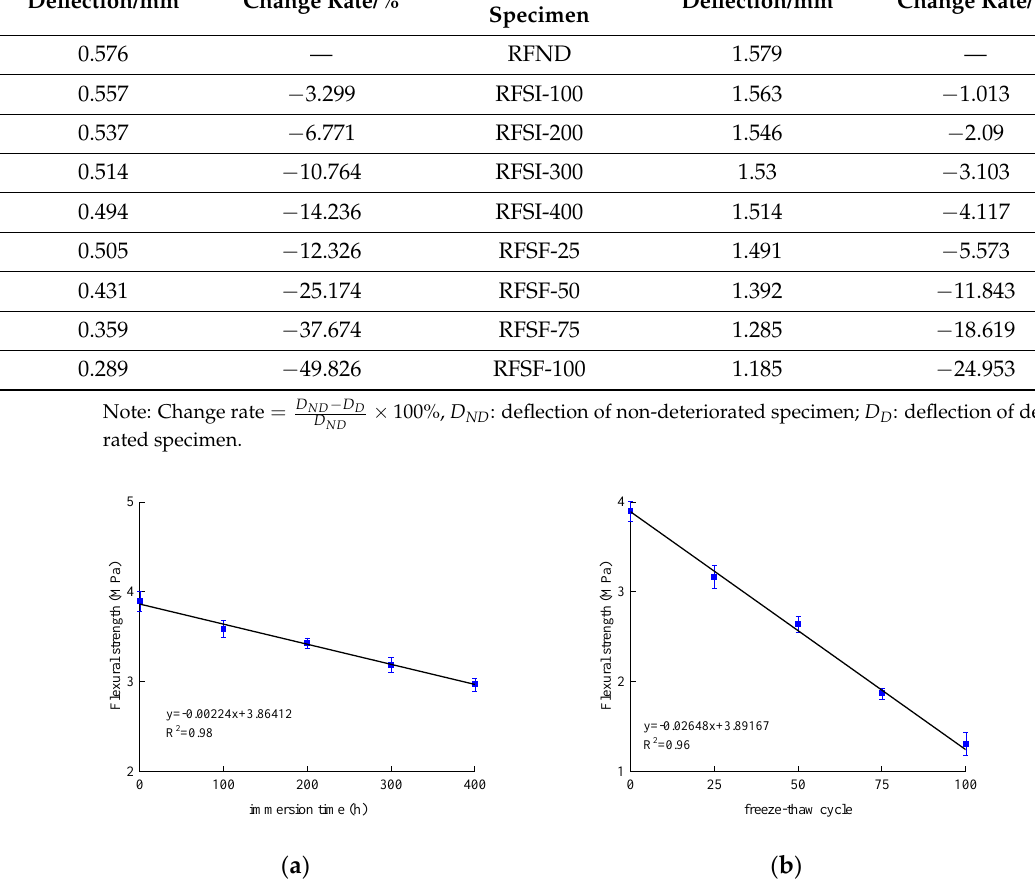
Figure 27. Flexural strength of unreinforced concrete specimen: ( a ) chlorine salt immersion environ- ment and ( b ) salt-freeze coupled environment.